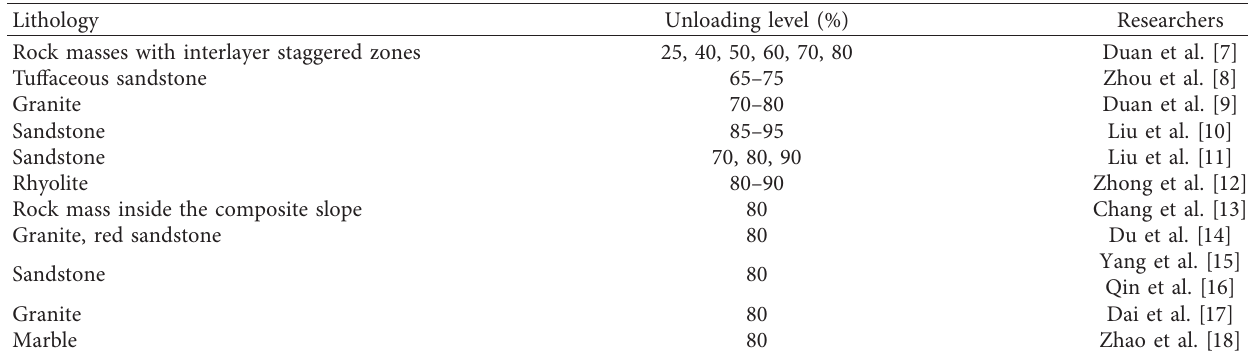
Table 1: Statistics of unloading level in rock unloading test.